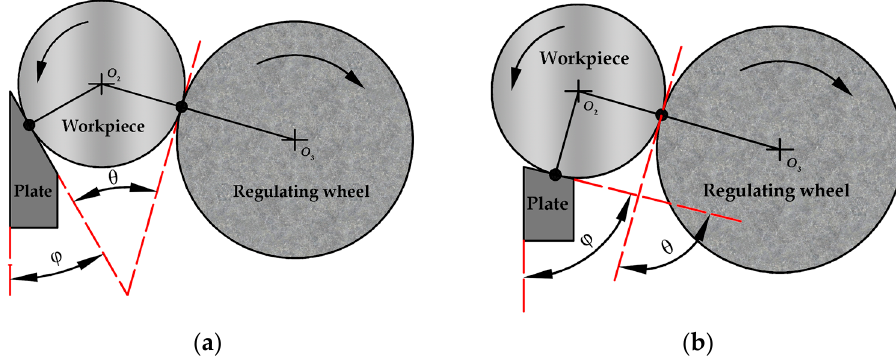
Figure 3. The mechanism of the influence of support plate angle on roundness error: ( a ) the support plate angle is too small; ( b ) the support plate angle is too large.